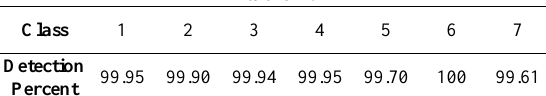
Table 2. Recognition rate for each group presented in table 1.